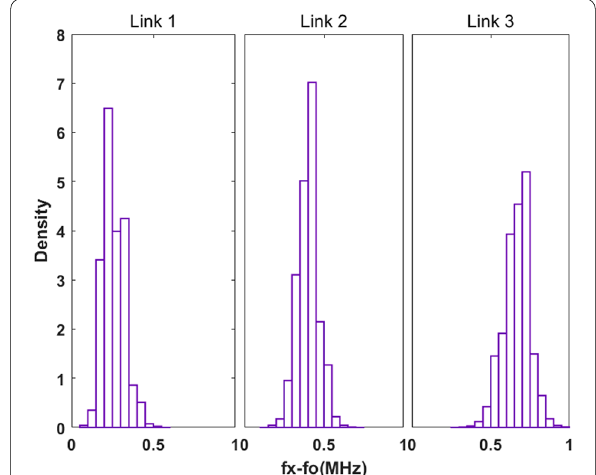
Fig. 3 Probability density of the separations observed through three radio